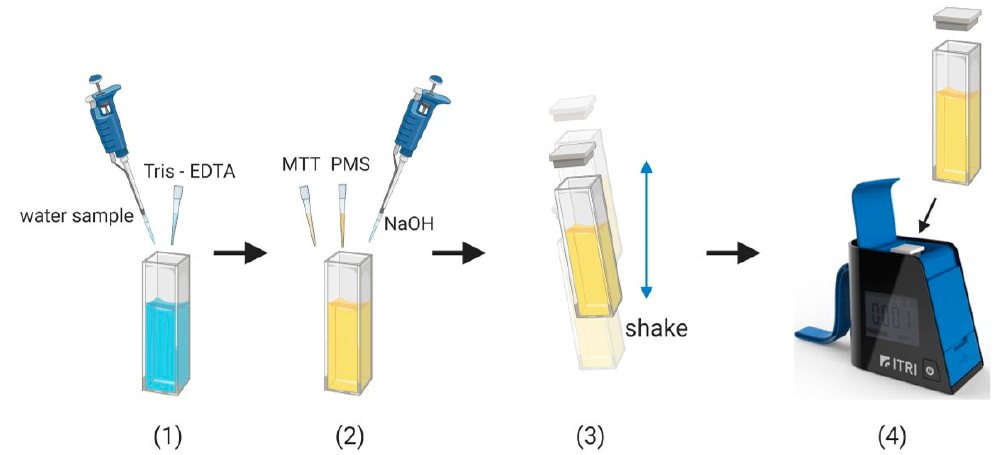
Figure 2. Step-by-step procedure chart for bacteria detection. ( 1 ) Add water sample and Tris-EDTA and incubate for five minutes. ( 2 ) Add the bacteria detection reagent and then quickly close the lid. ( 3 ) Shake for 3 s to mix the reagents quickly. ( 4 ) Put the cuvette into the colorimetric device and take measurements. Created with BioRender.com. (https://app.biorender.com/)